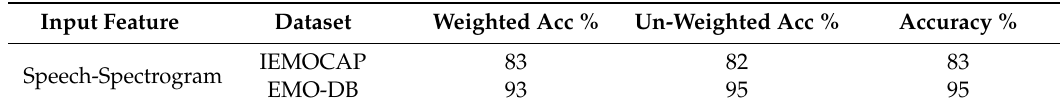
Table 4. Training evaluation of the proposed model using the IEMOCAP and the EMO-DB speech datasets.